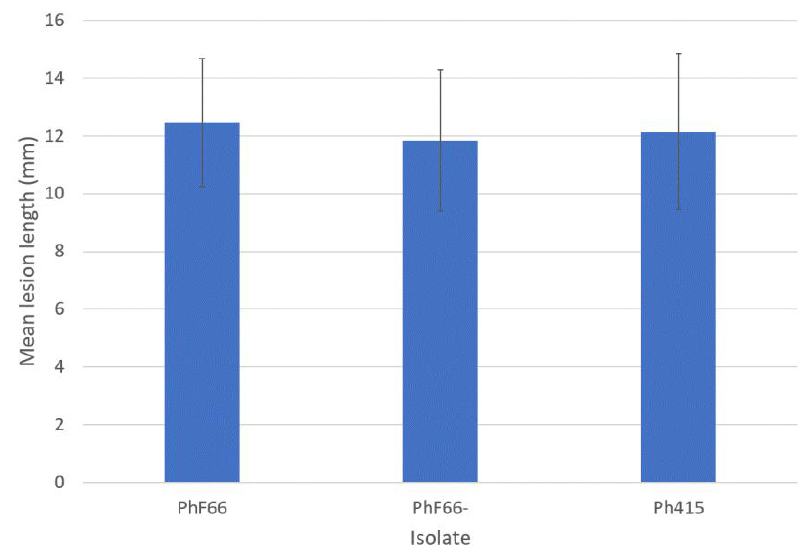
Figure 3. Mean lesion lengths from Phytophthora cactorum pathogenicity test on silver birch at 13 dpi. Error bars: 95% CI.